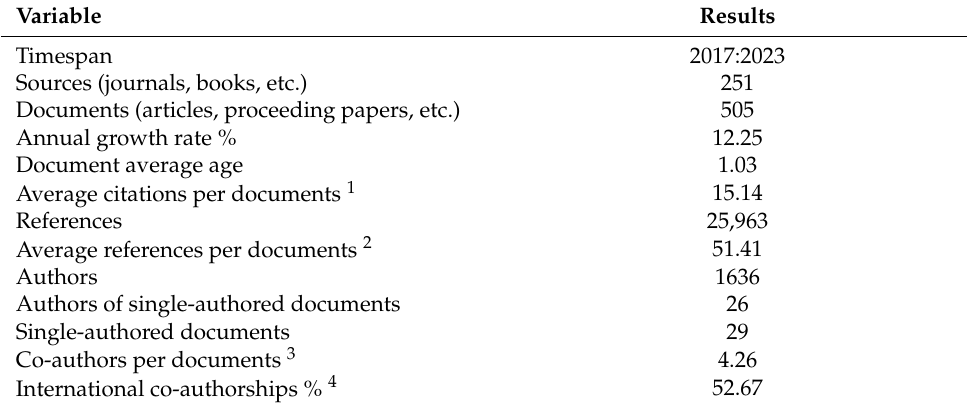
Table 1. Characteristics of the selected